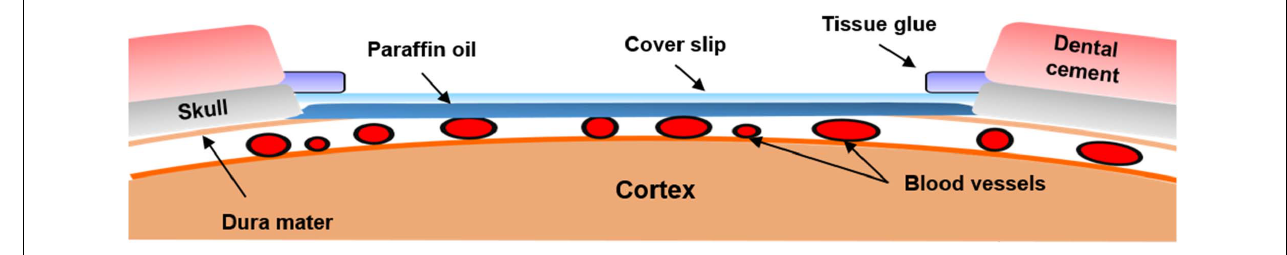
FIGURE 2 | Illustration of the chronic cranial window. Schematics of the cranial window on the rat cortex. The cranial window was filled with paraffin oil and covered by a cover slip. To maintain the intracranial pressure, tissue glue was used to seal the gaps between the skull and cover slip. After the cranial window was set up, dental cement was placed around the cranial window to avoid damage to the cover